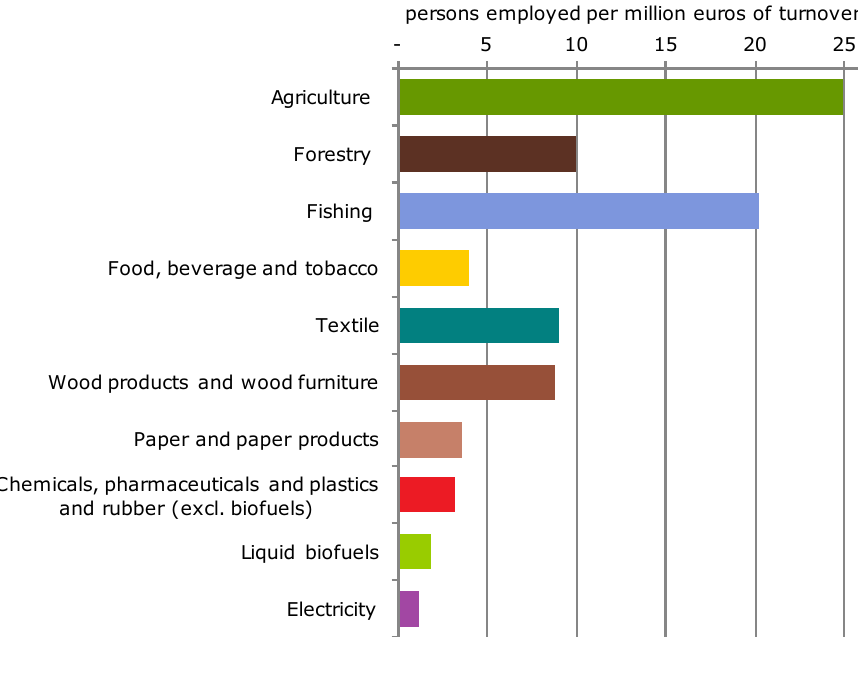
Figure 2 . Number of persons employed per million euros of turnover in the bioeconomy